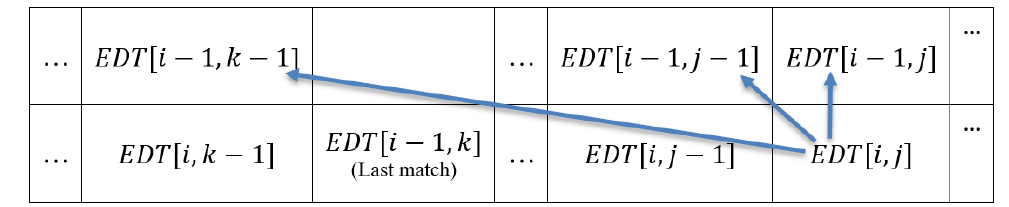
Figure 4. Redefining dependencies according to